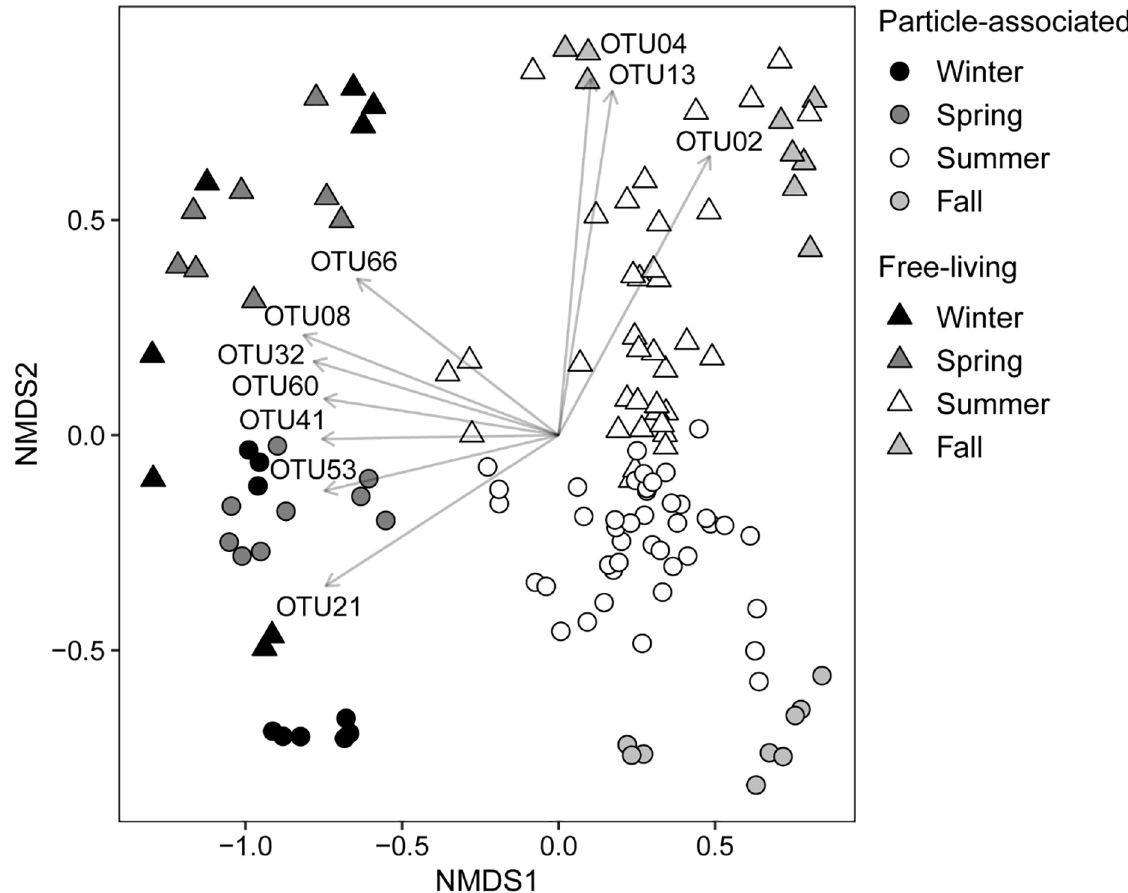
Fig 7. A NMDS ordination showing seasonal changes in composition of particle-associated and free-living bacterioplankton assemblages. Stress for the ordination equaled 0.11. Arrows indicate bacterial OTUs correlated (Envfit analysis: R 2 = 0.55–0.72, p = 0.001) with the ordination. Identifications of OTUs (RDP classification) are as follows: (OTU02 and OTU04) order Actinomycetales (Actinobacteria); (OTU08) family Comamonadaceae (Betaproteobacteria); (OTU13) class Betaproteobacteria (Proteobacteria); (OTU21) Prosthecobacter (Verrucomicrobia); (OTU32) Methylophilus (Proteobacteria); (OTU41 and OTU53) Flavobacterium (Bacteroidetes); (OTU060) phylum Bacteroidetes; and (OTU66) family Cytophagaceae (Bacteroidetes). Complete identifications of OTUs and specific R 2 values of correlations are presented in Table